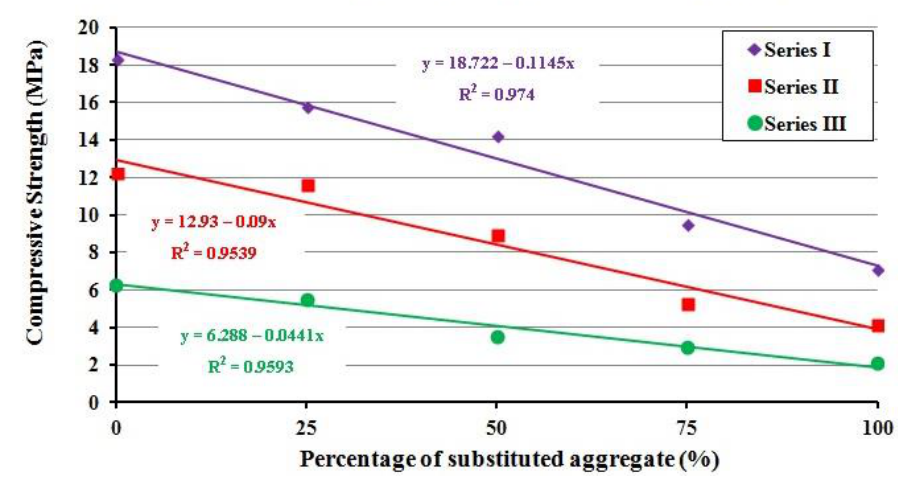
Figure 3. Density vs. percentage of substituted aggregate.